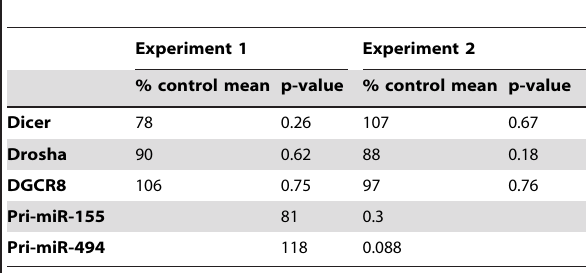
Table 4. Levels of Dicer, Drosha and DGCR8 mRNA are similar in depressed suicide subjects and normal